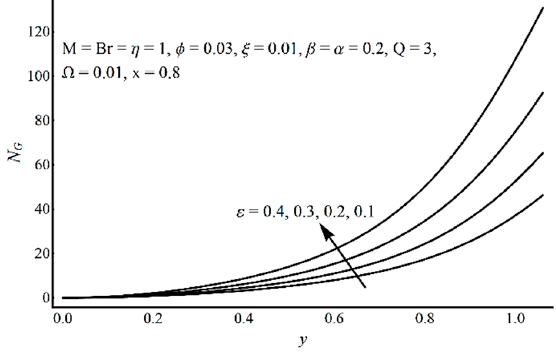
Figure 17. The total entropy generation number against various ε values.